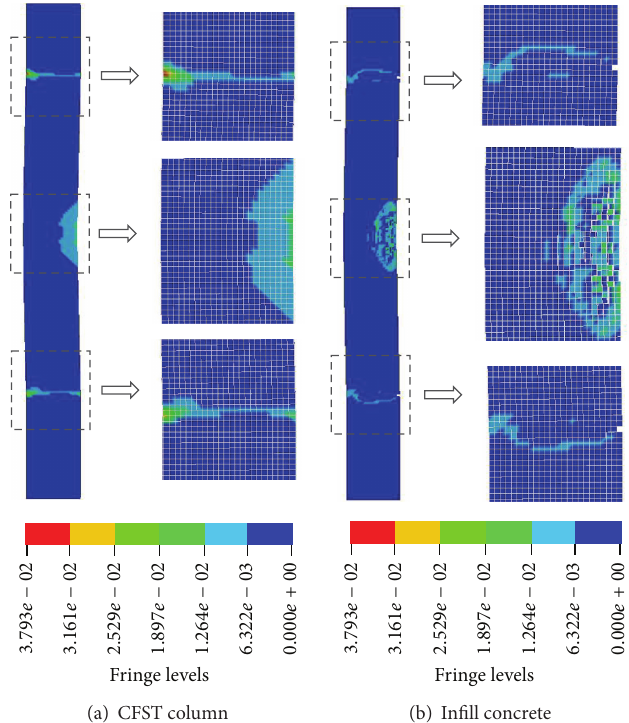
Figure 7: Flexural damage mode of CFST column under blast loading.